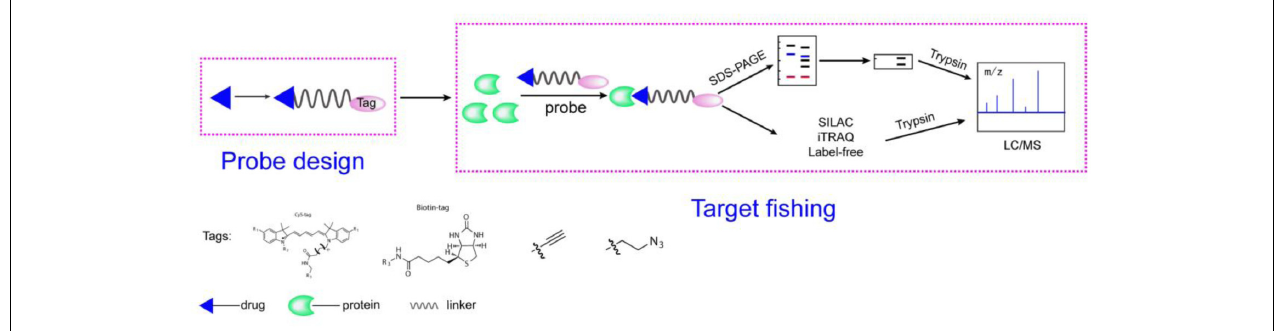
FIGURE 1 | A general representation of the ABPP workflow. The probe is designed based on the structure of the compounds, is added to the proteome and binds to its target protein. Gel-based method or quantitative approaches (label-free, iTRAQ, SILAC) for chemical proteomics experiments.